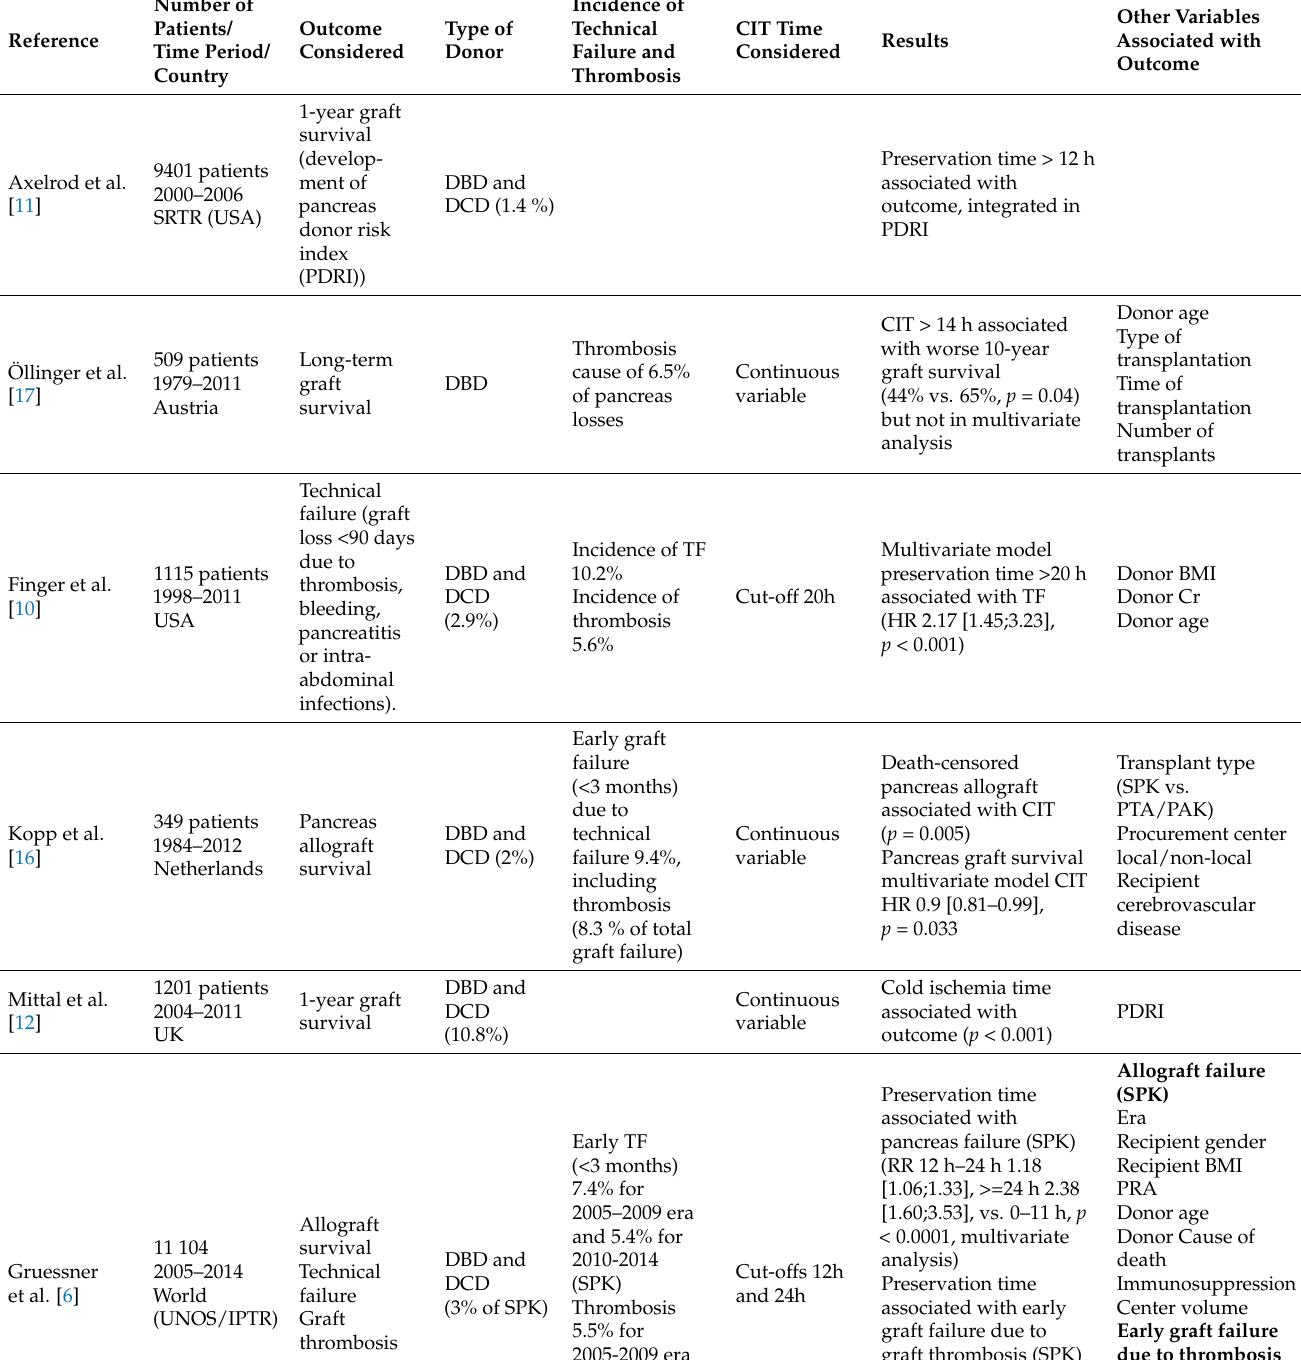
Table 1. Cold ischemia time and association with clinical outcomes in pancreas